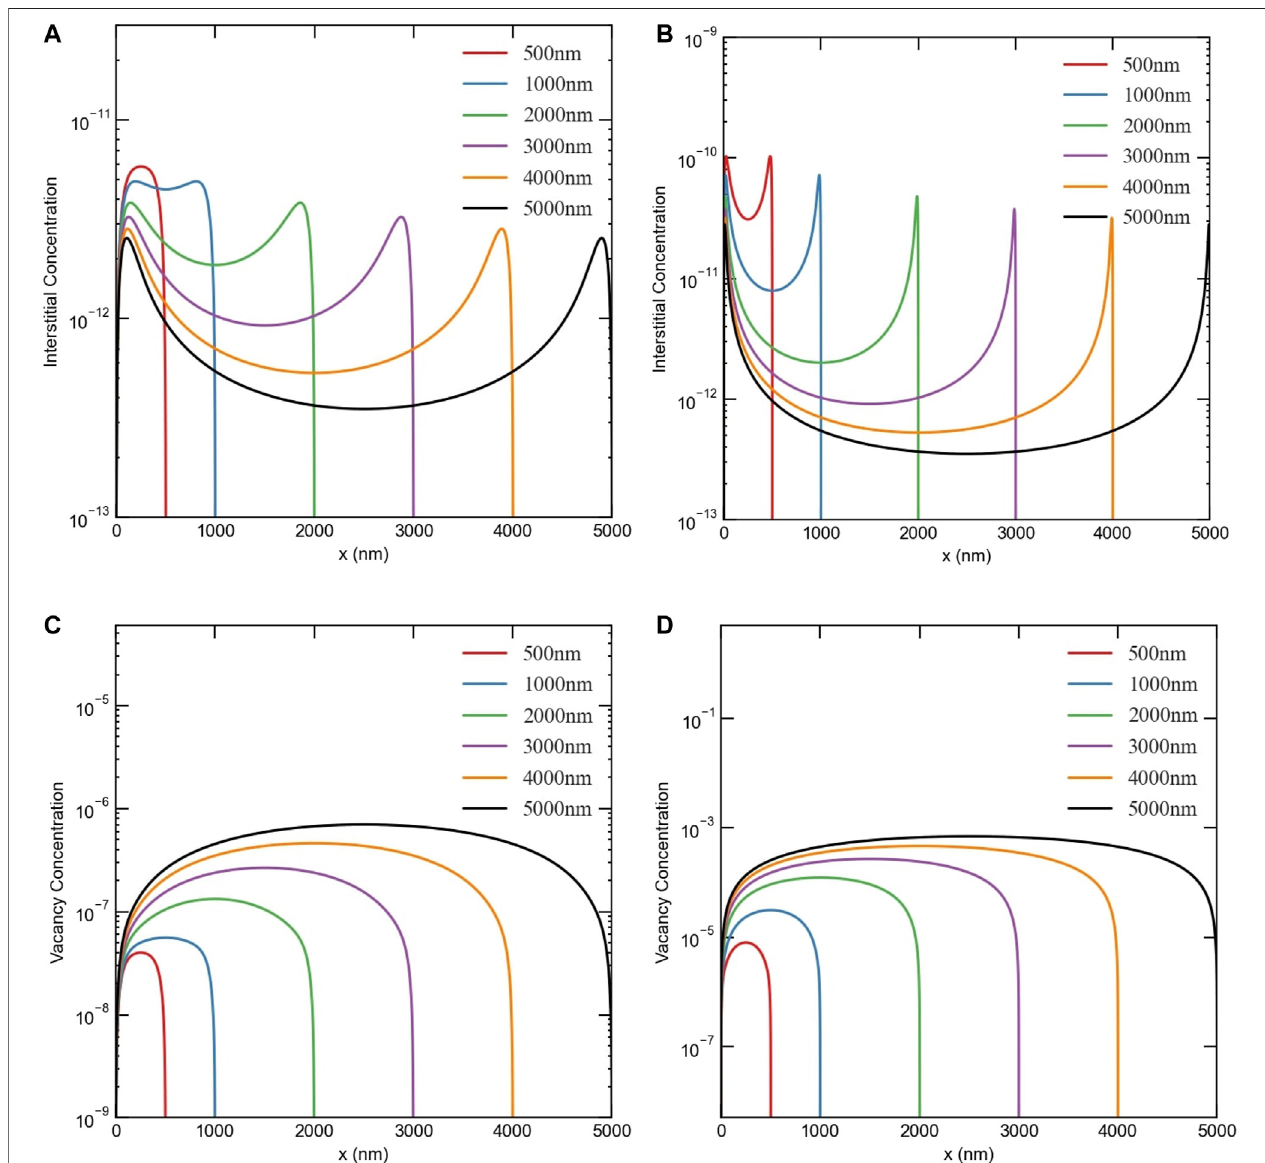
FIGURE 5 | Effect of grain size on the steady-state concentration pro fi les of point defects at 5% production bias. Upper row : interstitials at (A) low dose rate (1e- 6 dpa/s), (B) high dose rate (1e-3 dpa/s). Lower row : vacancies at (C) low dose rate (1e-6 dpa/s), (D) high dose rate (1e-3 dpa/s).